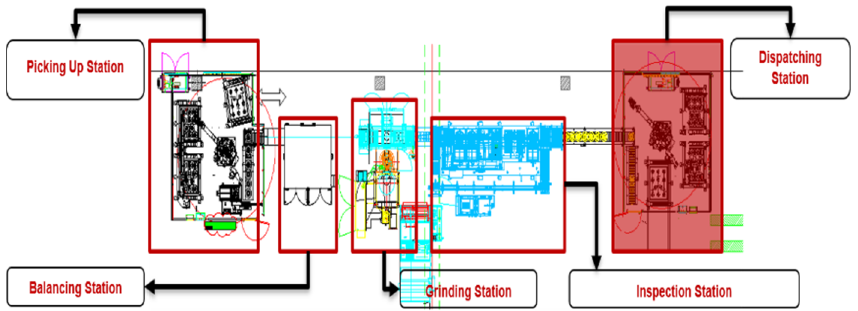
Figure 2. Architecture of brake disc production line.